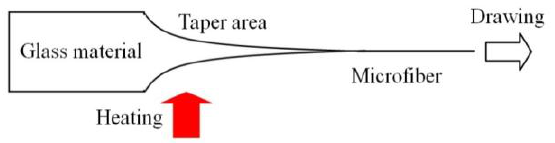
Figure 5. Schematic diagram of taper-drawing